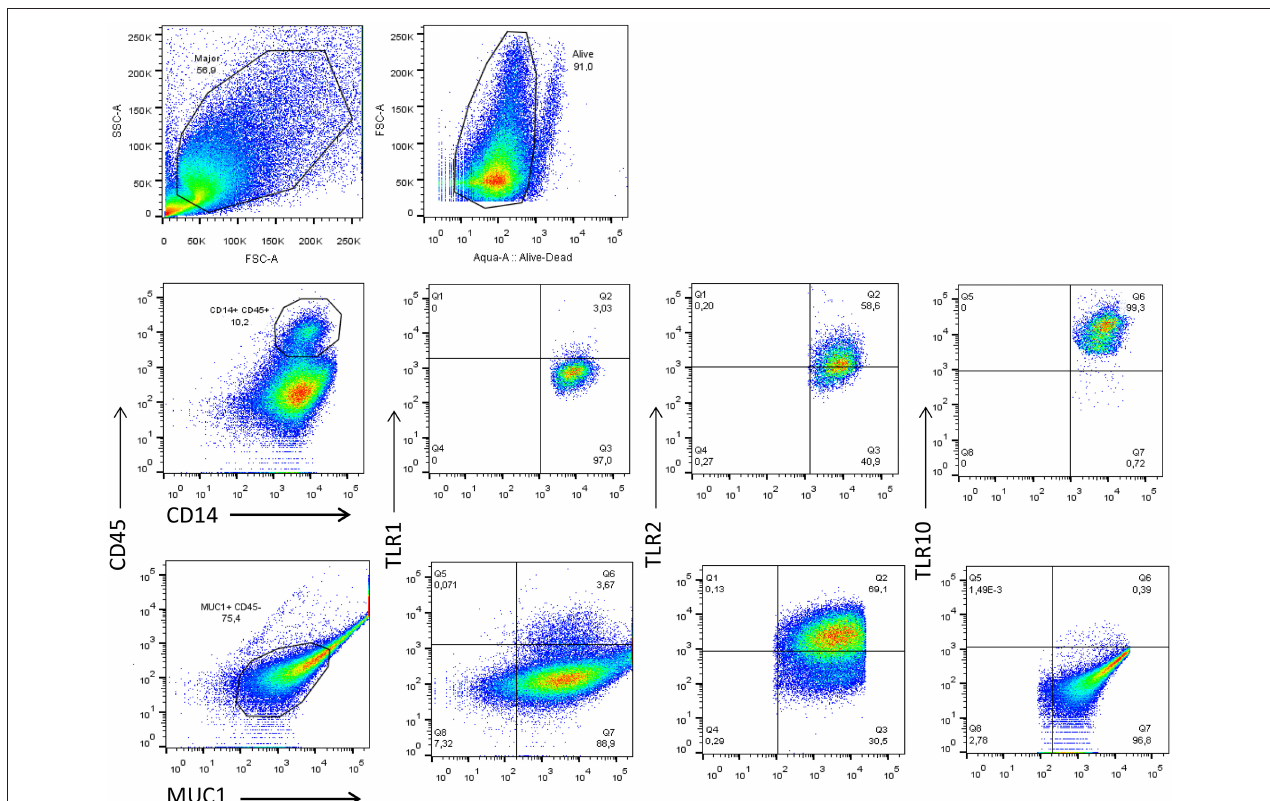
FIGURE 1 | Flow cytometry analyses of TLR1, TLR2, and TLR10 expression in the two major types of primary BM cells obtained from HIV-1 uninfected women at 3 months post-partum. Leucocytes were gated with CD45-PerCP-Cy5.5 and CD14-V450 whereas the epithelial cells were gated with MUC1-PE-Cy7 and CD45-. The antibodies TLR1-APC TLR2-APC and TLR10-PE were separately used to detect TLR1, TLR2, and TLR10 in CD14 + -CD45 + -MUC1 − and MUC1 + -CD45 − cell types to differentiate the two major constituents of BM. Representative images are shown with TLR1, TLR2, and TLR10 expression depicted as percentages on right corner of each